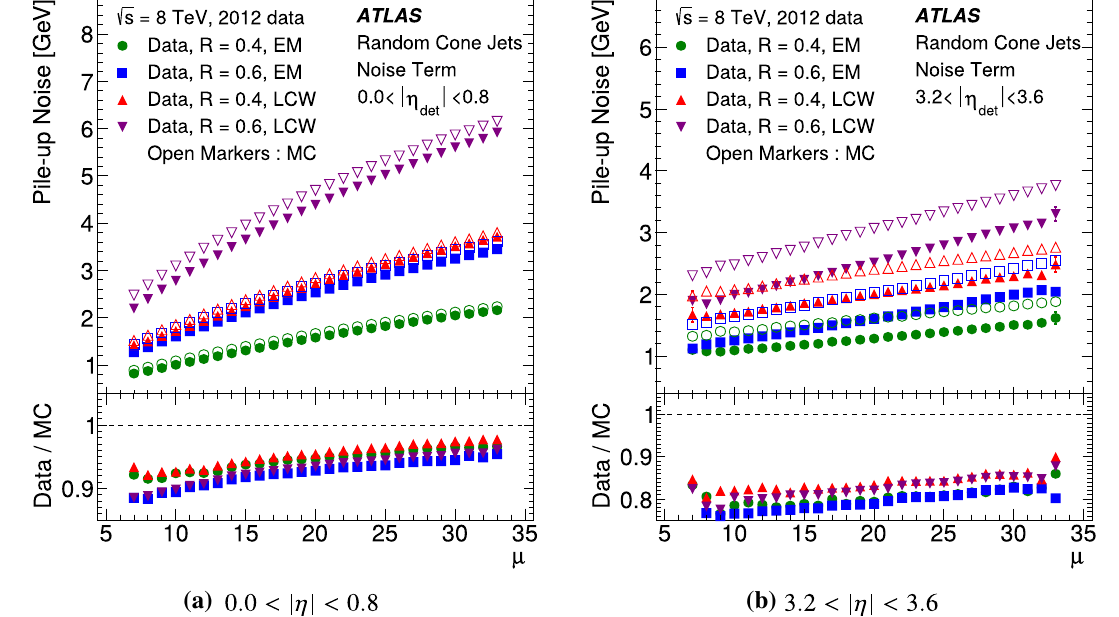
Fig. 50 The balance of random cones of size 0.4 ( (cid:8) p T = p 1 clusters. The non-Gaussian shape of this distribution is demonstrated by the inclusion of a Gaussian fit (dashed lines) to the data (solid lines)